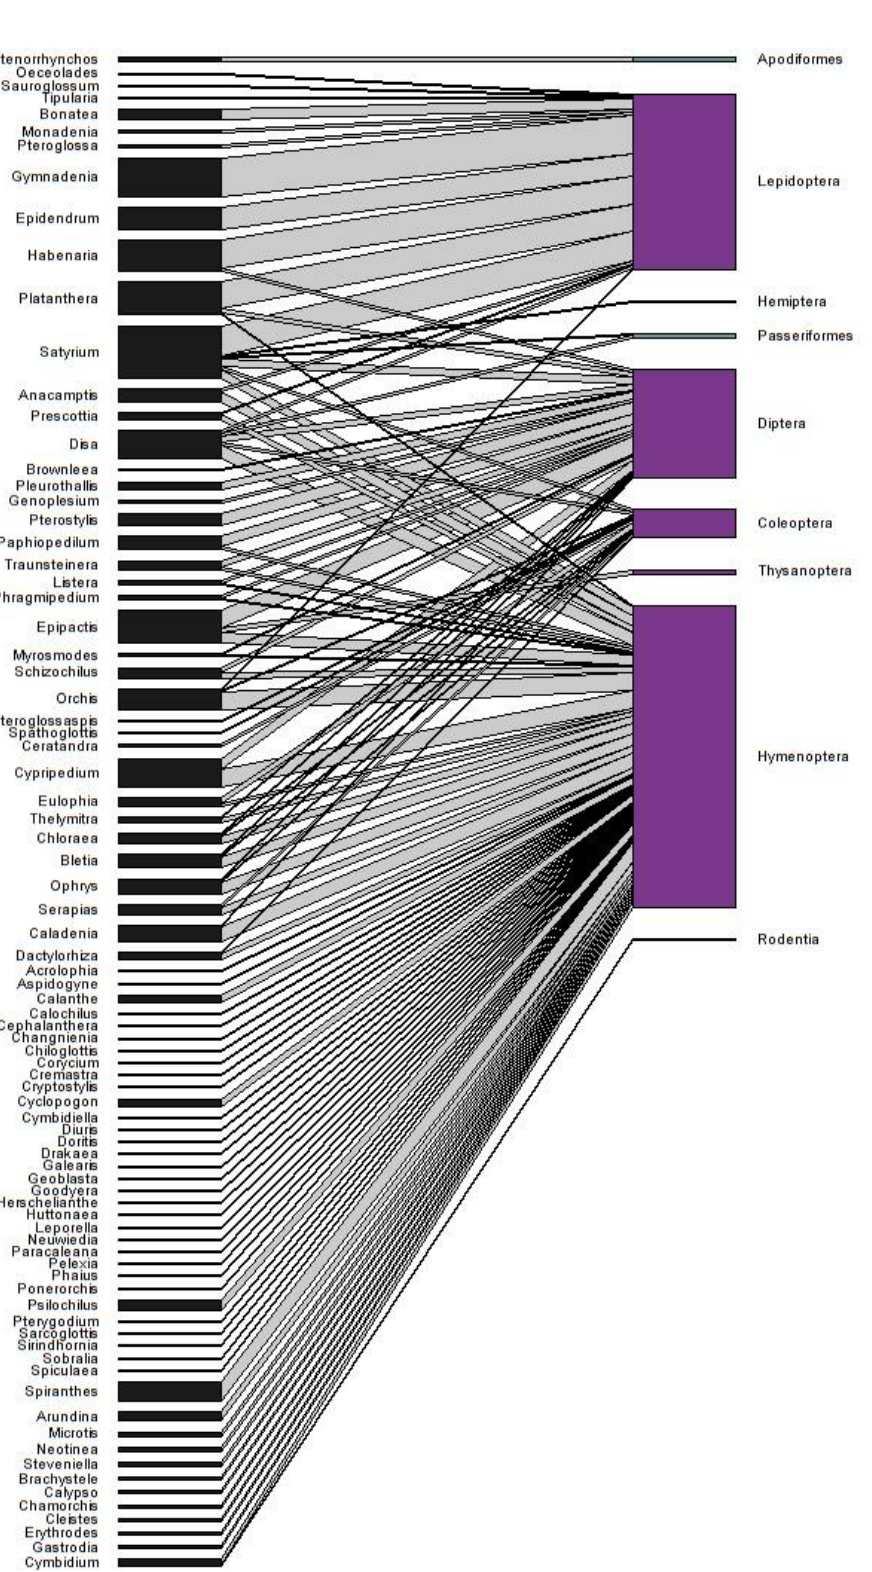
Figure 4. Bipartite interaction web of terrestrial orchid genera (left) and the taxa that have been observed as pollinators (right). Each bar represents at least one instance of a pollinator interaction between the two taxa. The thicker the connecting bars are between the two groups, the more documented instances of pollination by a species in that genus have occurred. The order of the taxa was arranged by R to show the fewest number of overlapping bars. Taxa with purple bars represent insects, while taxa with blue bars represent